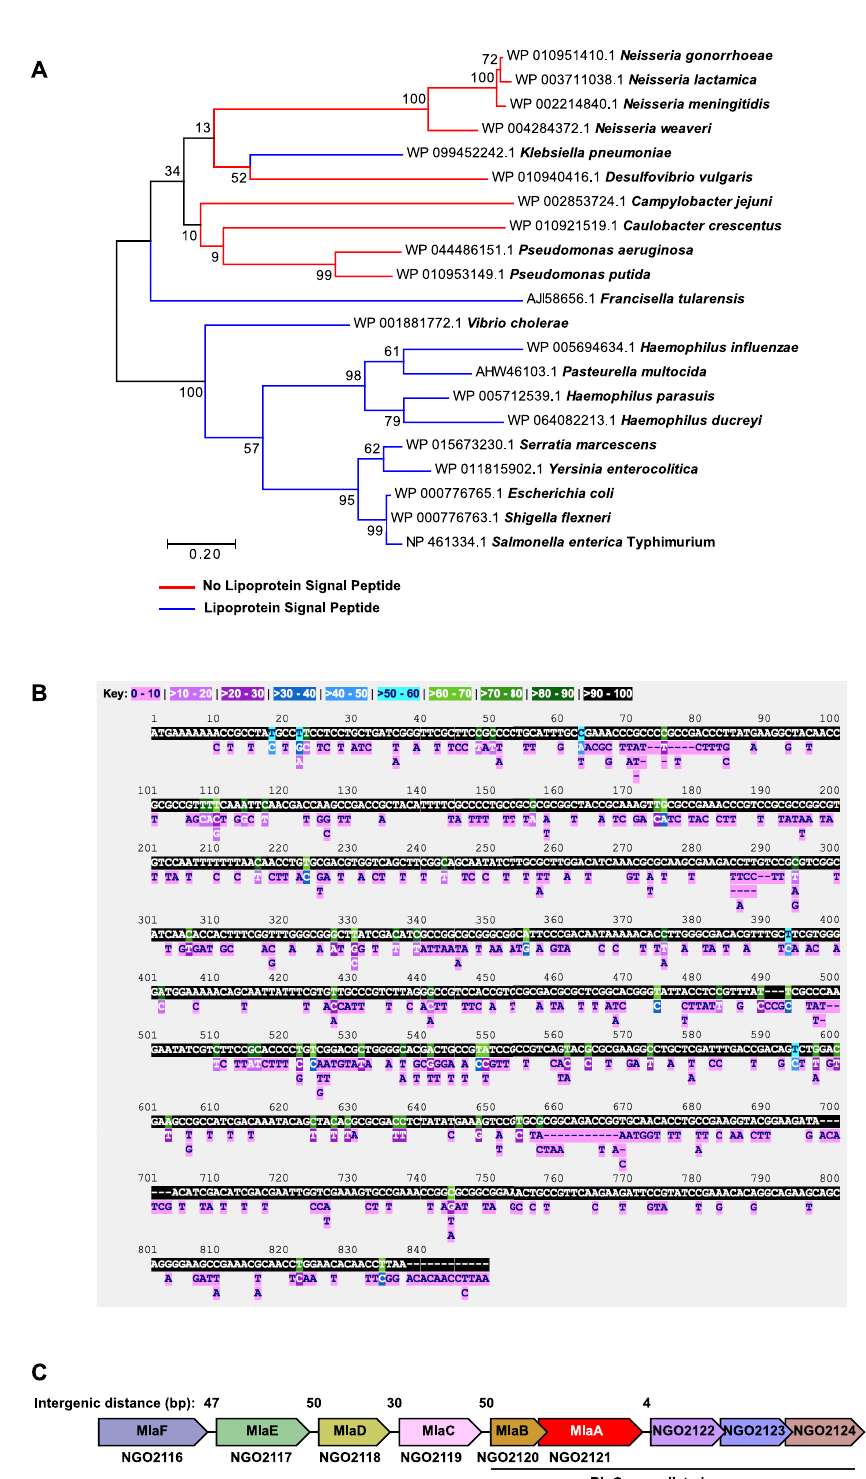
Fig 2. Bioinformatic analysis of MlaA conservation and genome context. (A) A phylogenetic tree of MlaA was constructed in MEGA using amino acid sequences of MlaA/VacJ homologs downloaded from NCBI. The Jones- Taylor-Thornton model was used to generate a pairwise distance matrix. Neighbor-Join and BioNJ algorithms were subsequently applied to the matrix to obtain the initial tree for a heuristic search. 500 bootstrap iterations were performed to test the phylogenies. The highest log-likelihood tree is presented. Homologs without lipoprotein